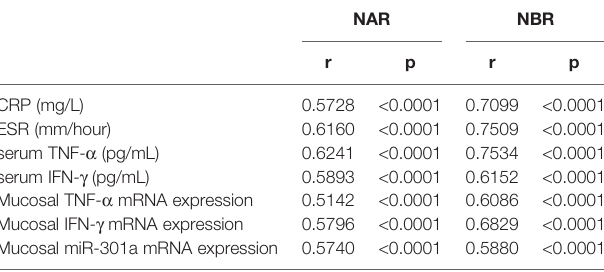
TABLE 3 | Associations of NAR and NBR with in fl ammatory load in CD